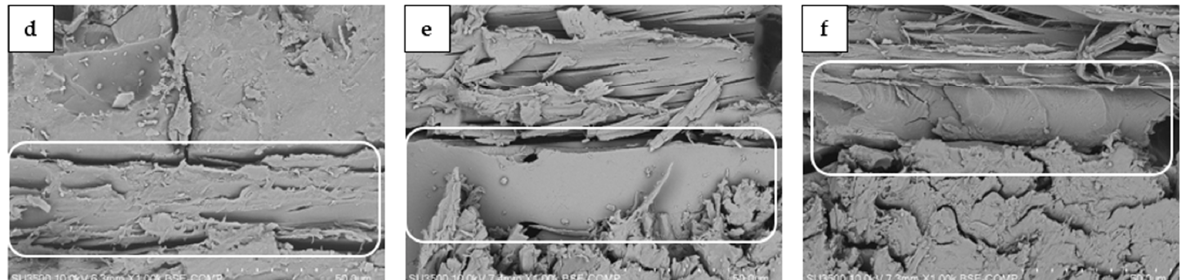
Figure 5. SEM photos of cross-section plywood: ( a , d )—REF; ( b , e )—B-1; ( c , f )—B-5 samples. The bond lines are marked with white frames box.